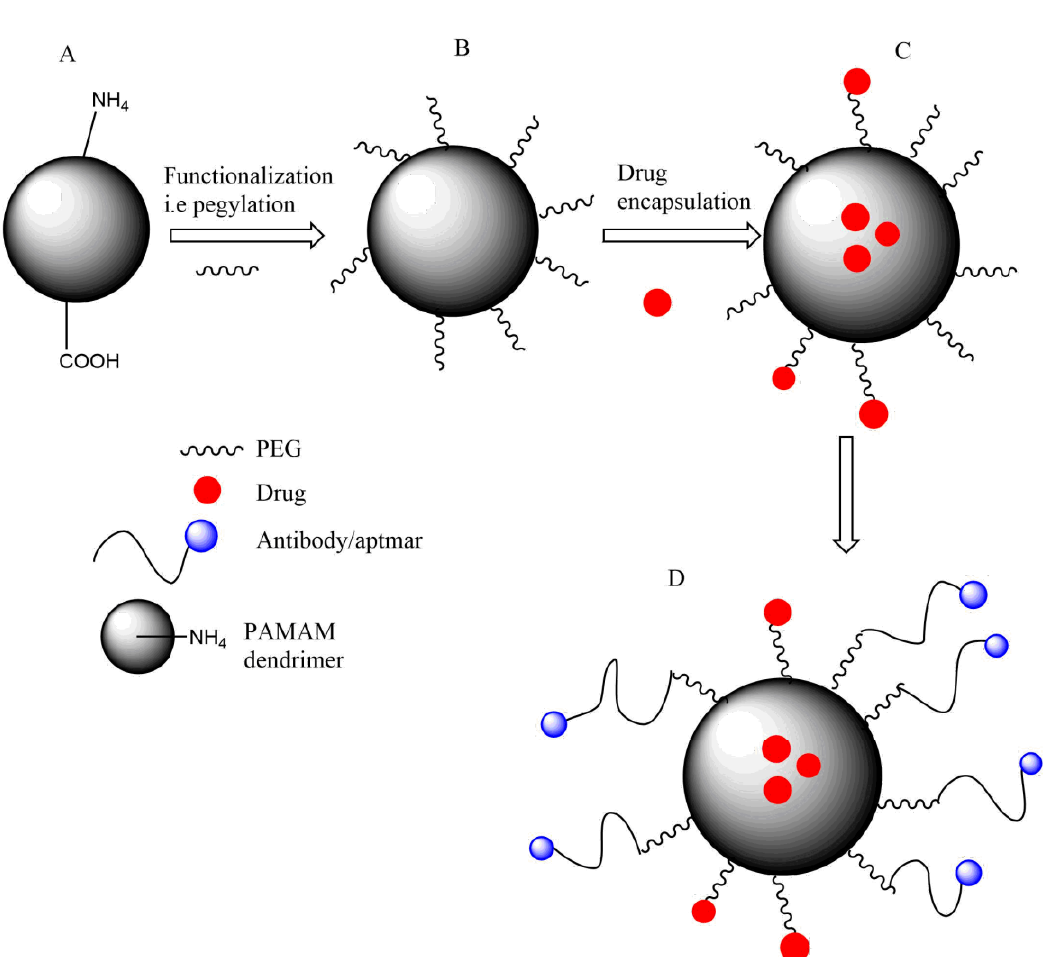
Figure 2. A cartoon scheme showing functionalization and conjugation to PAMAM dendrimer. PAMAM dendrimer can be functionalized by pegylation as indicated in B , normally PEG is used to modify the surface of the PAMAM dendrimer. Functionalized PAMAM dendrimer can be used to encapsulate drugs to improve solubility and biodistribution as shown in C . Drugs into PAMAM dendrimer can be encapsulated into the interior core of the dendrimer or can be conjugated into the surface of the dendrimer. D shows that functionalized PAMAM dendrimer can further be conjugated with special ligands such as antibody/aptamer for improved targeted drug delivery.